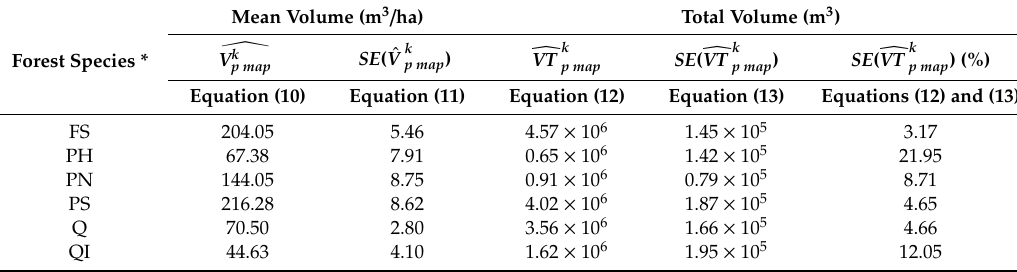
Table 4. Volume estimates and standard errors based on uncertainty in the Landsat forest species map .